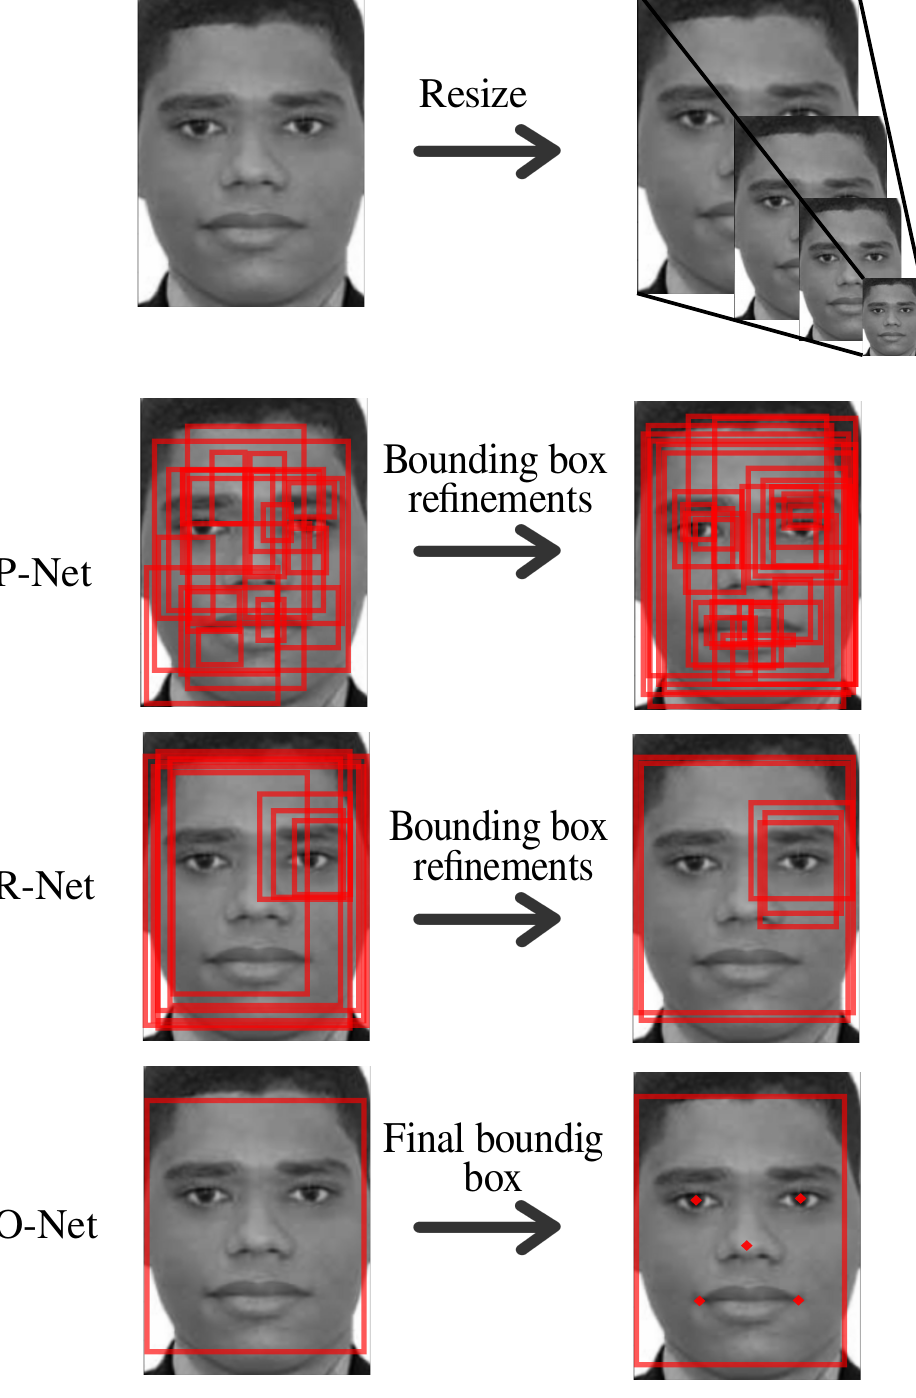
Figure 6. MTCNN sequence to find a face in an